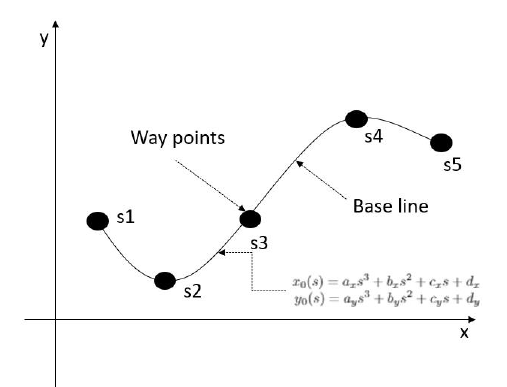
Figure 4. Baseline and way-points in the Cartesian coordinates: cubic spline baseline function from way-points s 1 – s 5